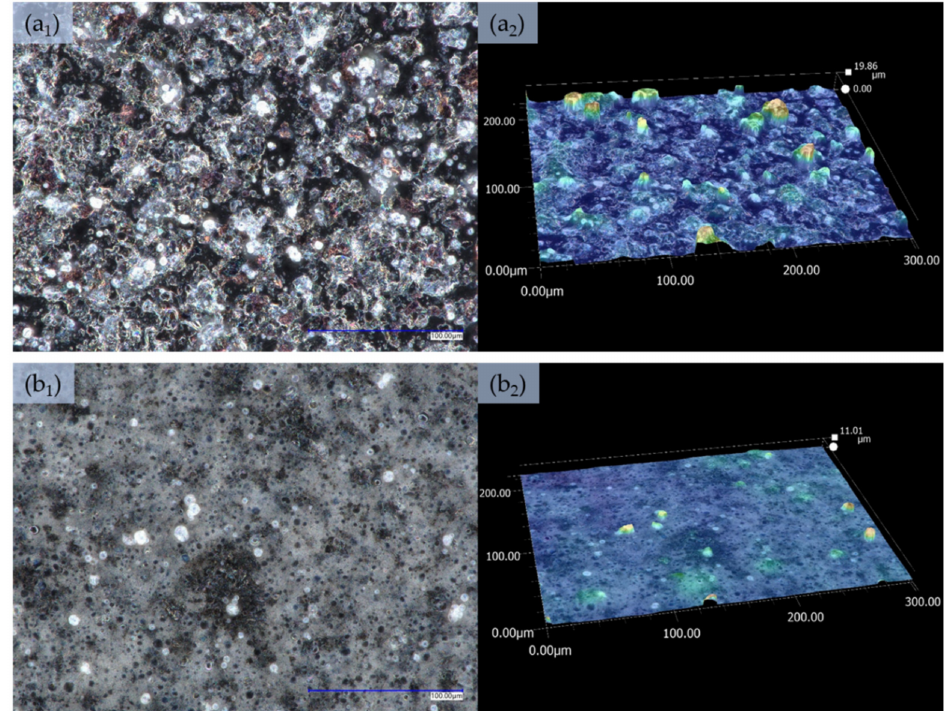
Figure 2. Images from an optical microscope presenting the morphology of films (mag × 1000) produced by spraying, and the depth profiles presenting the roughness of the layers (mag ×